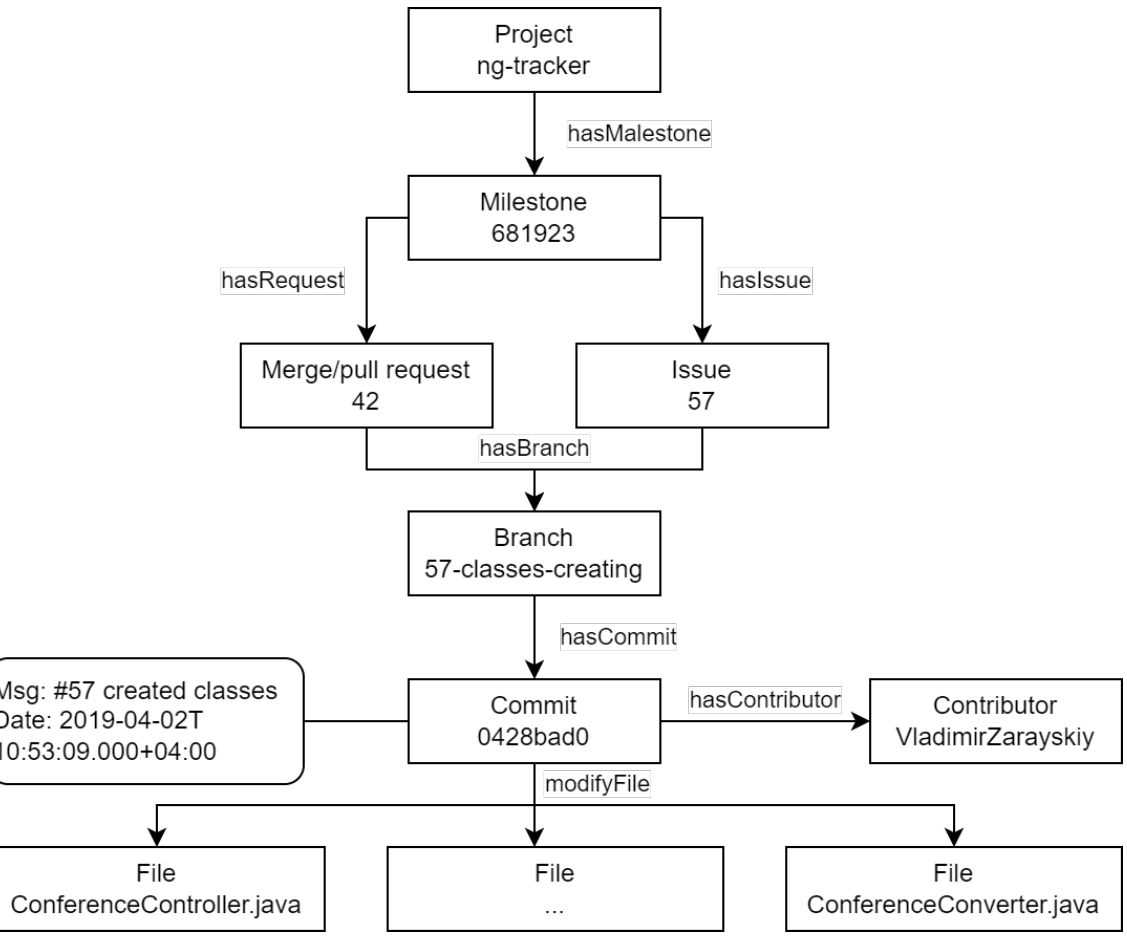
Figure 3. Example of the L B representation